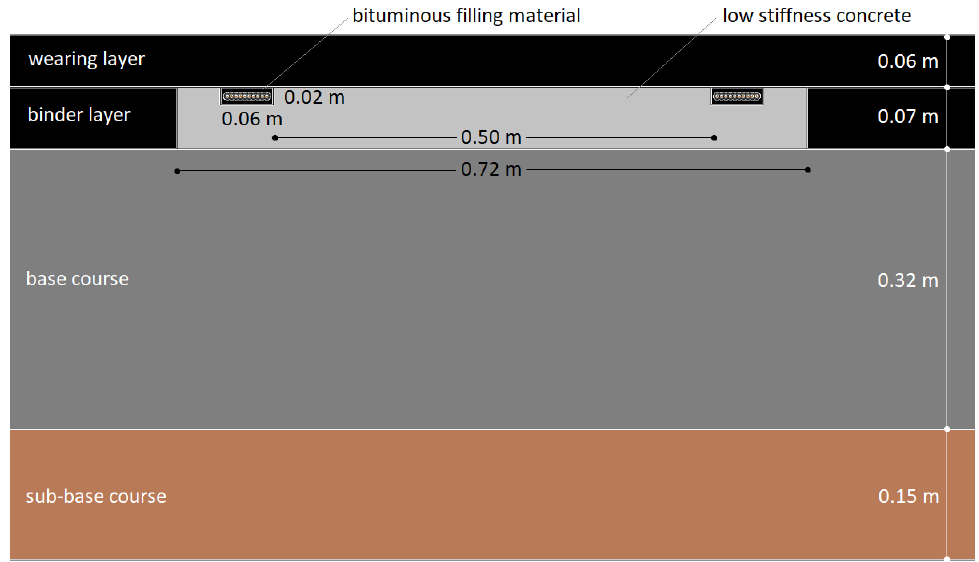
Figure 4. The section of the POLITO solution adapted for motorway applications.